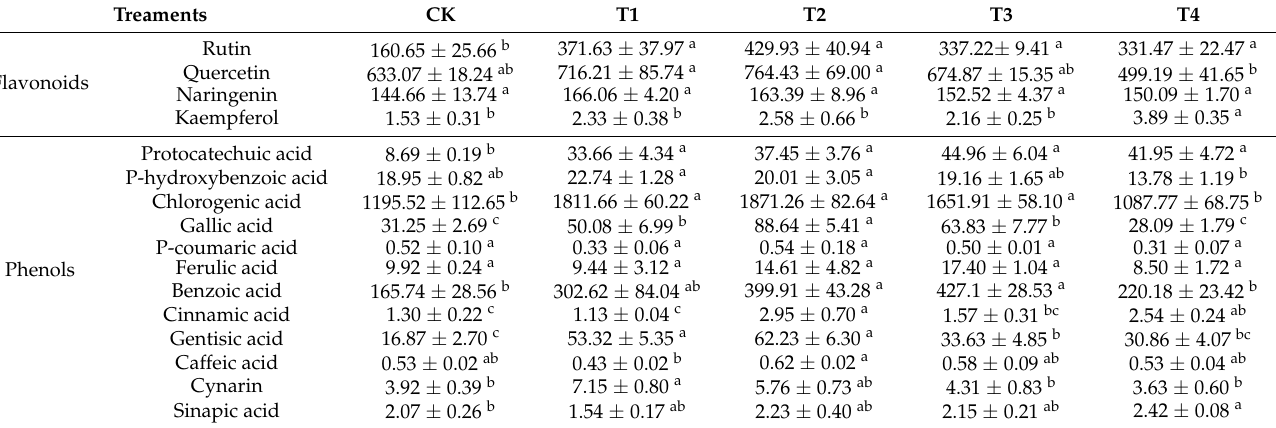
Table 1. Effect of different levels of water deficit on the content of polyphenol components ( µ g g − 1 DW) in tomato fruit.